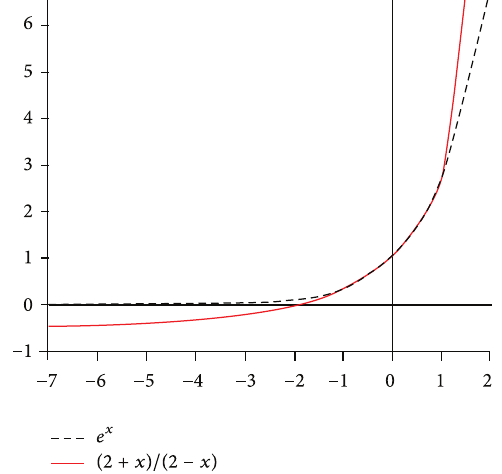
Figure 2: Approximating 𝑒 𝑥 using a simple rational function.